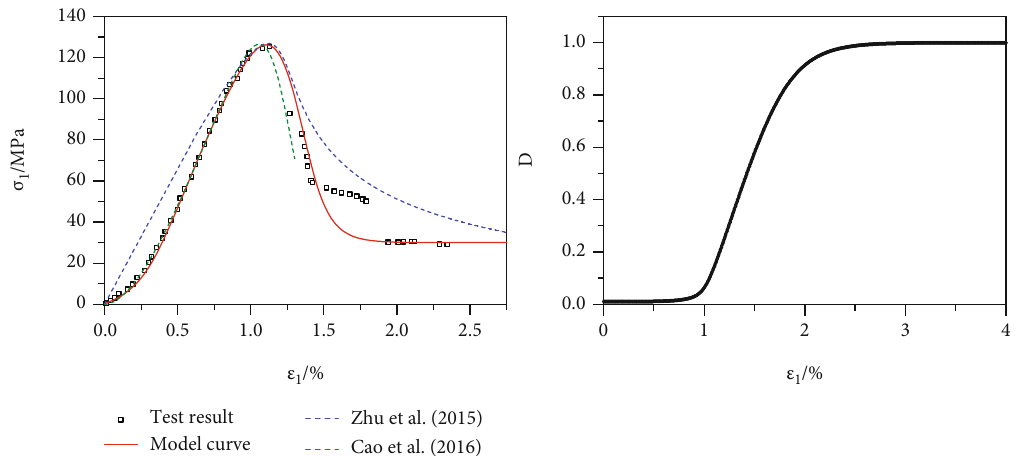
Figure 13: Axial stress-strain curve and damage curve under con fi ning pressure of 5MPa.